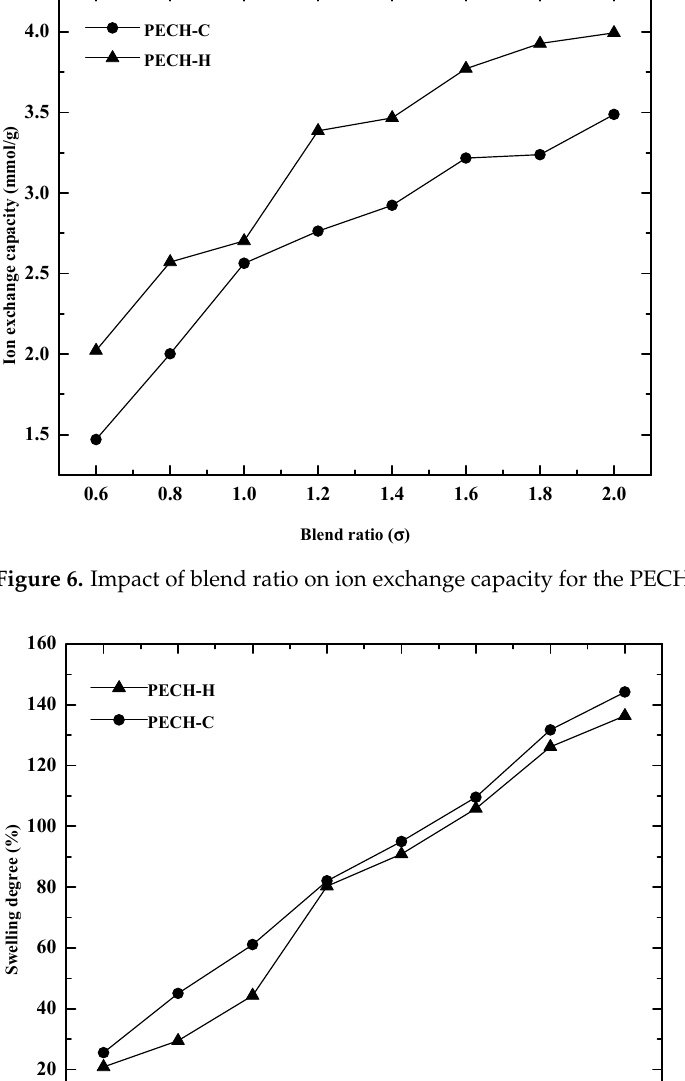
Membranes 2022 , 12 , x